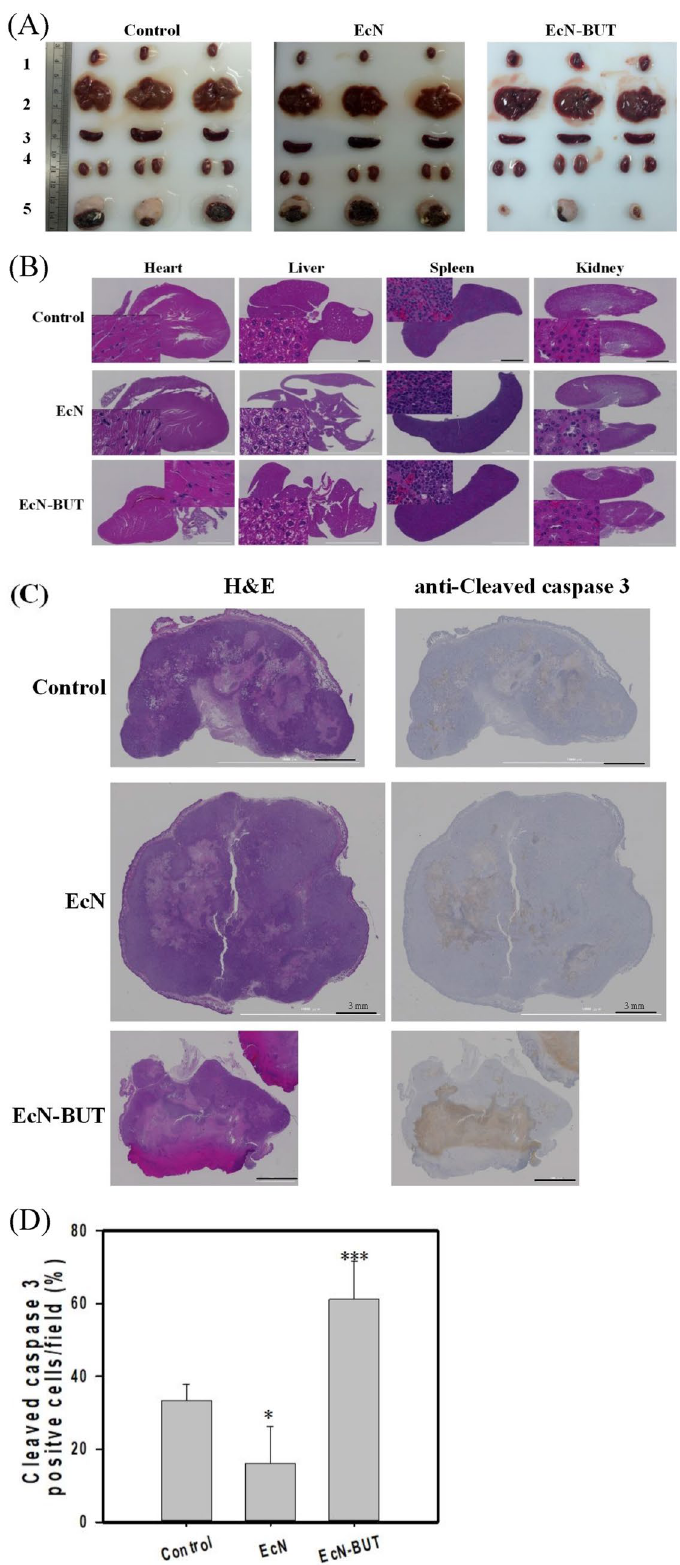
Figure 7. Analysis of tumor tissues and organs. ( A ) Organ and tumor sections. Photographs showed the appearance of organs and tumors size for each tested group. ( B ) H&E staining of organs. H&E staining was applied to analyze nuclear chromatin (purple-blue) and cytoplasm (red). ( C ) H&E and IHC analysis of cleaved caspase-3. The tumor-bearing mice were administrated with EcN-BUT, EcN, or PBS (control). The IHC analysis was performed by applying the anti-cleaved caspase-3 antibody to tumor tissues after the treatment. ( D ) Quantification of cleaved caspase-3. Data were taken from three independent experiments by the ImageJ Image Analysis software and analyzed using the GraphPad Prism 7 software (* p < 0.05, ** p < 0.01 and *** p < 0.001 vs. control based on two-tailed t test) and graphs were prepared using SigmaPlot 10.0 (Systat Software, San Jose,